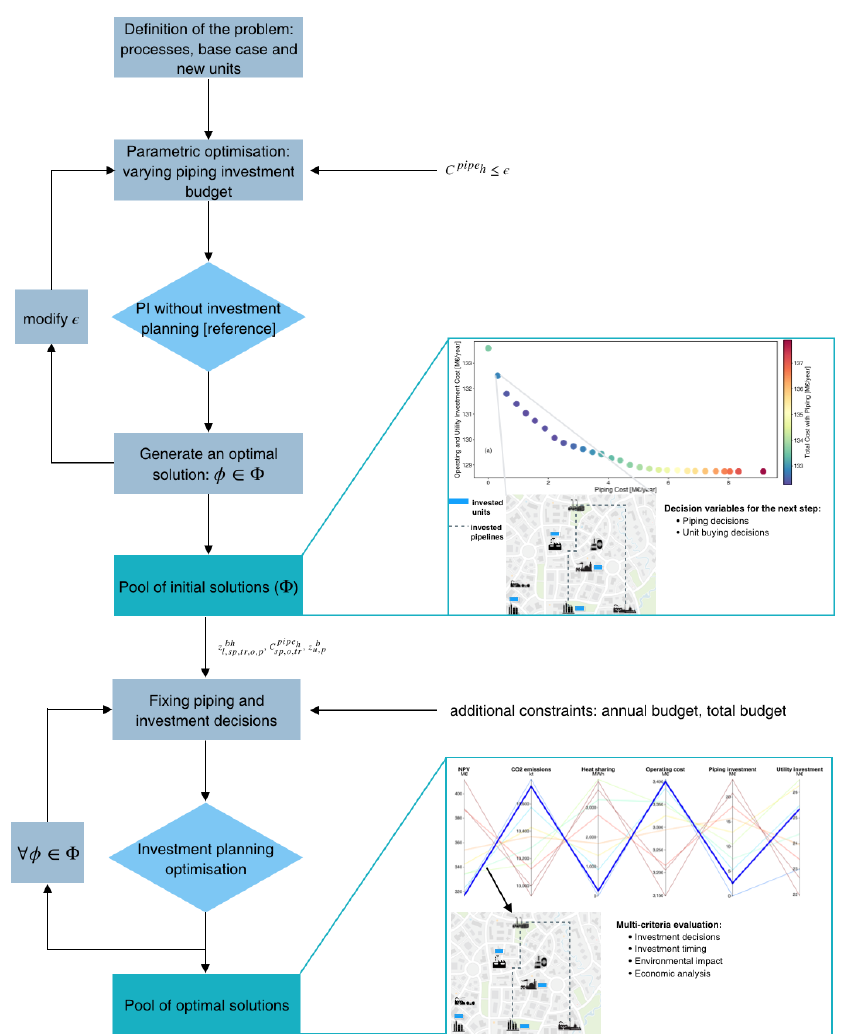
Figure 4. Parametric optimisation solution strategy: targeting and